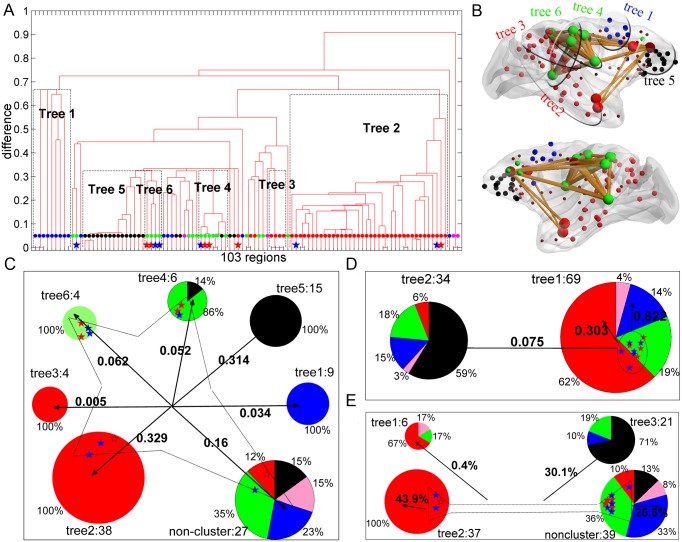
The LDCs affect the functional segregation and integrations.(A) Hierarchical tree of the real macaque cortical network. The color of dots represents the corresponding function (visual: red, somatosensory: green, motor: blue, temporal: pink and frontal: black). The red stars indicate the 6 core special areas of LDCs, and the blue stars for the rest 6 LDCs. (B) Spatial distribution of different sub-trees in the real network mapped on the cortical surface using BrainNet Viewer [81]. The LDCs in the sub-trees are shown as big balls with connections among each other. (C, D, E) Hierarchical modular organization of the cortical connectome, the reconstructed network at α = 0.006, and a randomized network (‘R-network’), respectively. Every pie in (C), (D) or (E) represents a hierarchical sub-tree (connectivity module) dominated by areas of a certain functional modality (matching ratio > 50%) in the corresponding network. The number of areas is listed next to the tree. The areas not involved in any hierarchical tree are combined into the “non-cluster” pie. The colors in the pie represent different functional systems (as in Fig 3B and 3A), and the corresponding ratios of these systems in a given hierarchical sub-tree are listed. The original LDCs belonging to different sub-tree or non-cluster groups are shown by stars. These areas are grouped together by light solid lines with a diamond shape for the real network (C), by the shape of the circle in the reconstructed network (D), or by the shape of a hammer in the R-network (E). The arrows from the group of the special areas indicate the distribution of the links of this group to other sub-trees, with the ratio listed by bold fonts near the corresponding arrows.